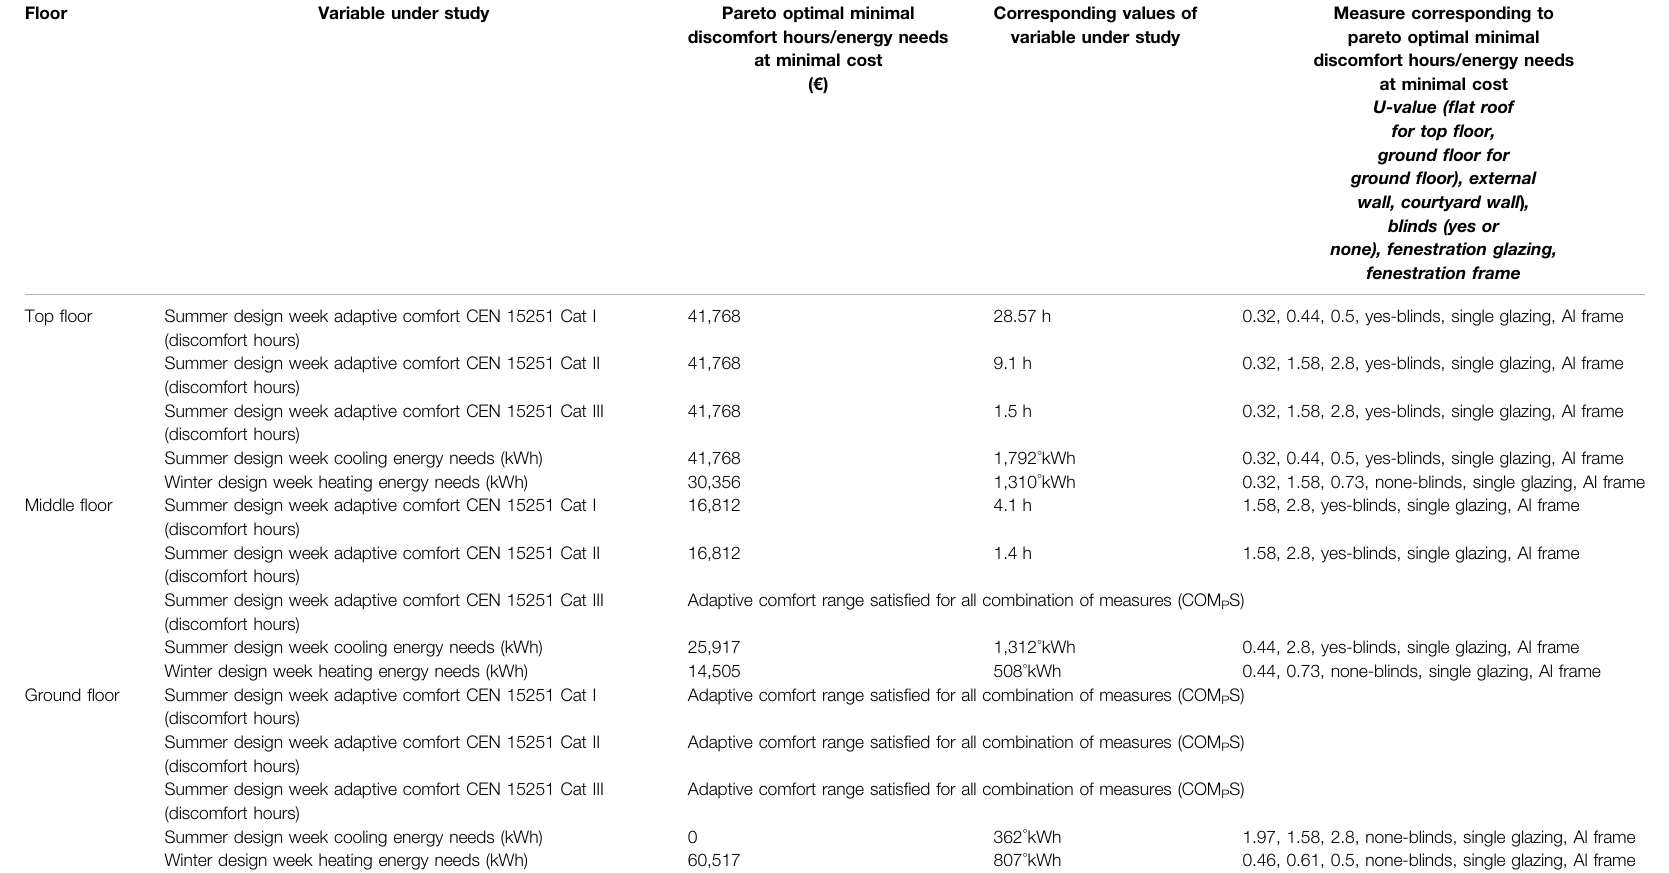
TABLE 2 | Passive measures (COM P S) corresponding to the pareto optimal discomfort hours, cooling and heating energy needs at minimal cost for the top, middle and ground fl oors. Floor Variable under study Pareto optimal minimal